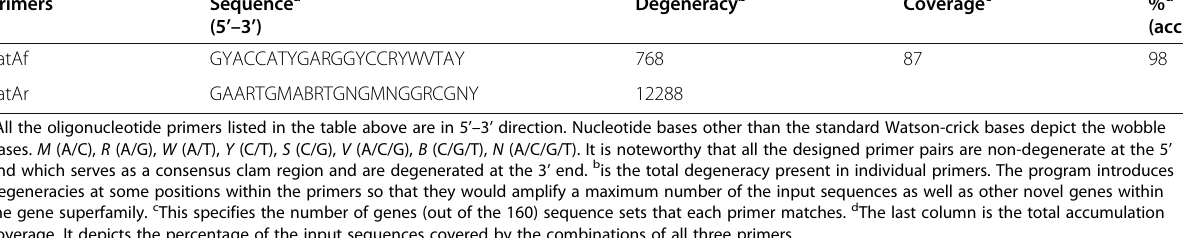
Table 2 Degenerate primer pairs for amplification of aromatic compound dioxygenase gene families. Primers